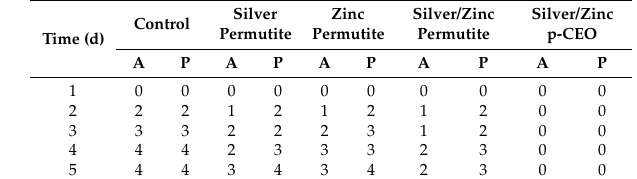
Table 3. Evaluation table of mold growth.